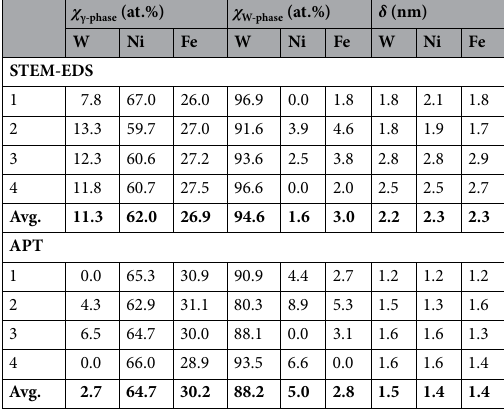
Table 1. List of calculated bulk compositions and interfacial width as determined from STEM-EDS and APT analyses.